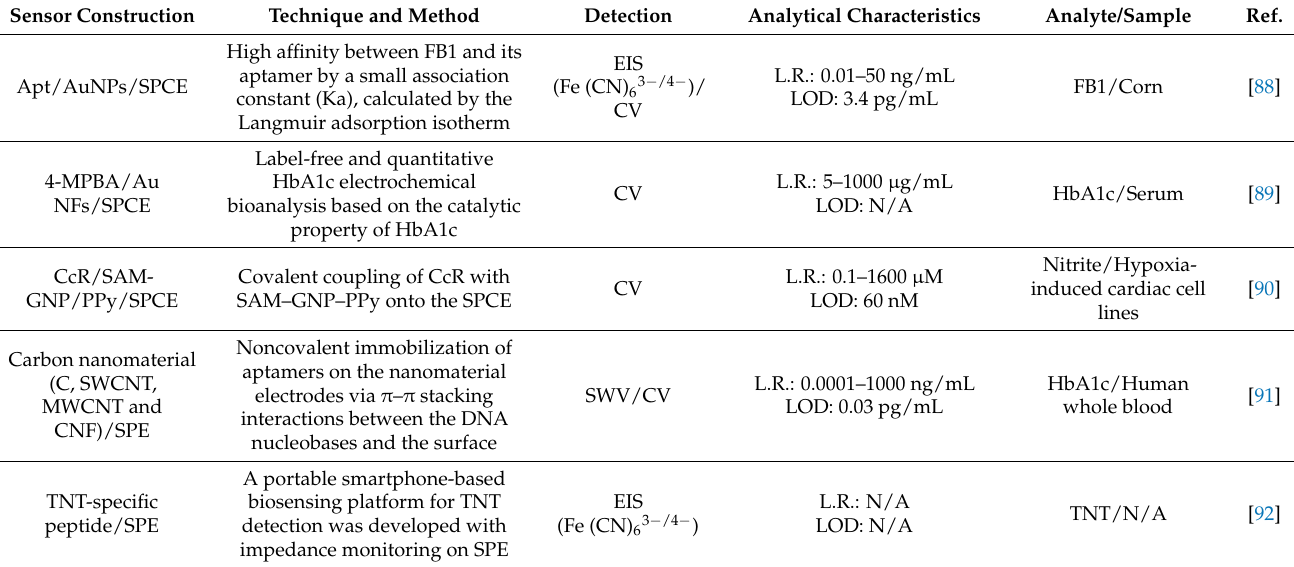
Figure 6. Schematic of aptasensor construction. Inset: responses of CSPE/OMC-TPS/aptamer-MB without insulin ( a ) and with insulin ( b ) (adapted and reprinted with permission from [107]). Table 2. SPE aptasensors for (bio)compound detection in some